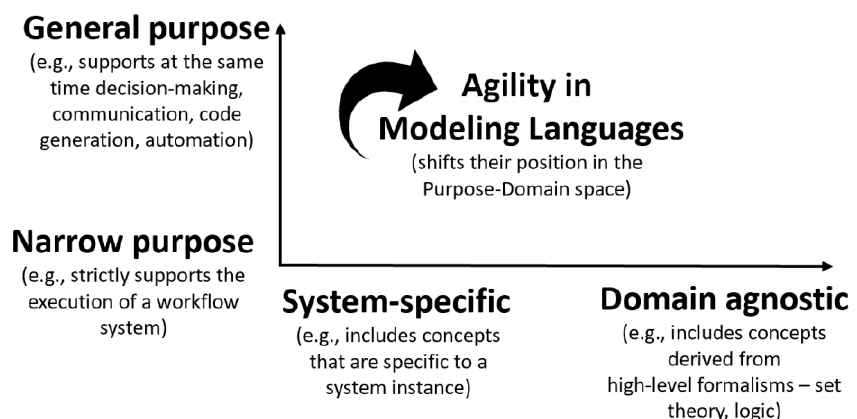
Figure 3. Expanding the general-purpose/domain-specific dichotomy to a Purpose-Domain space